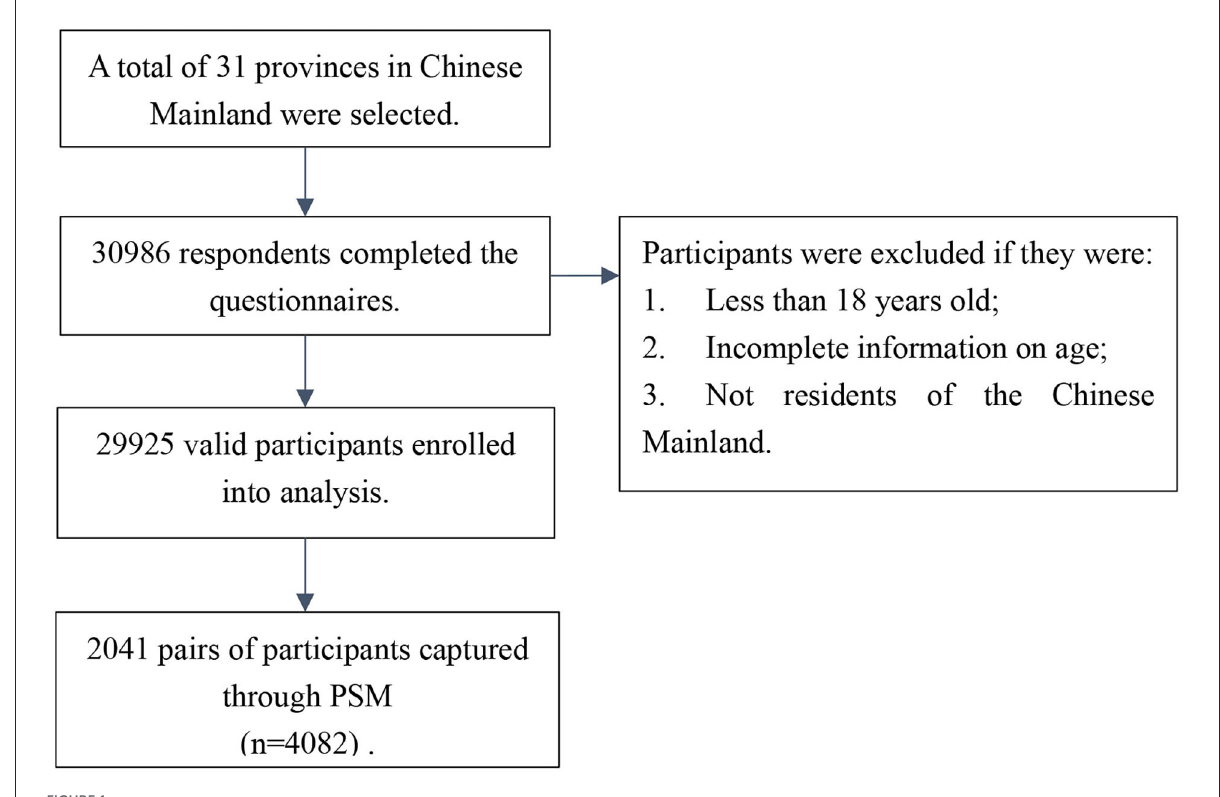
FIGURE1 The flowchart of participant selection.